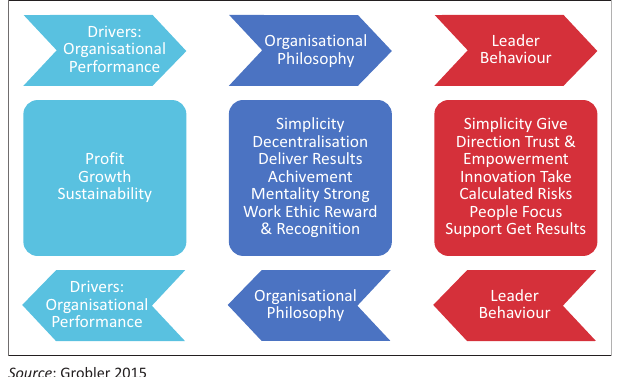
FIGURE 5: Perpetual cycle of influence between organisational drivers, organisational philosophy, and leader